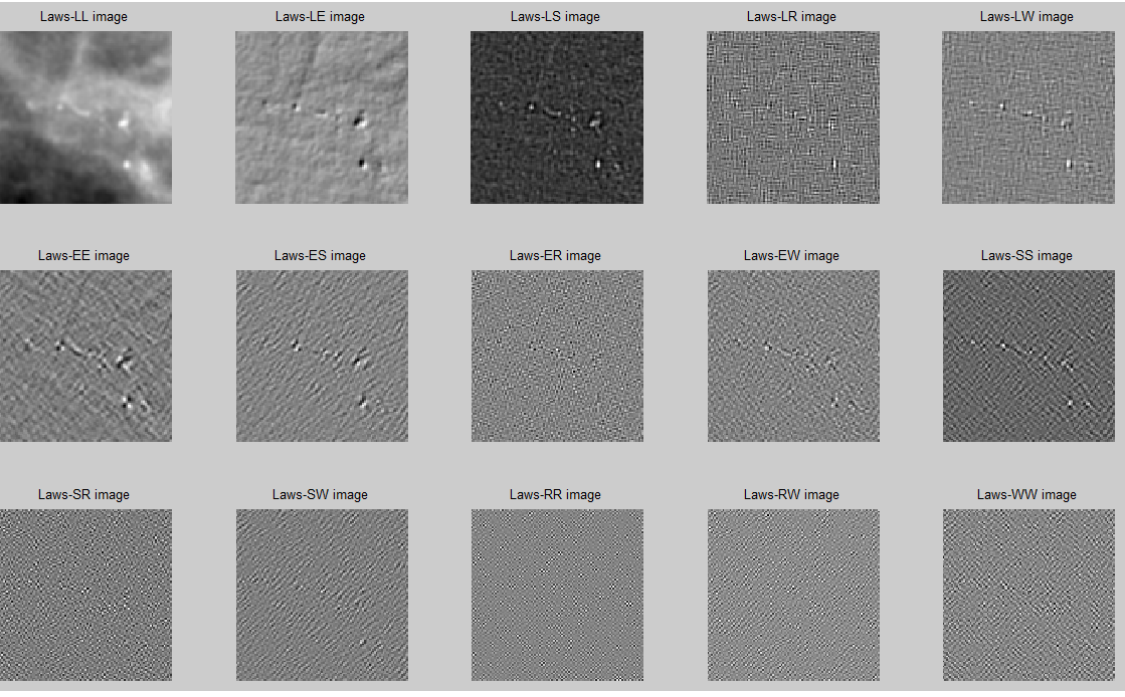
Figure 6. The results after Laws